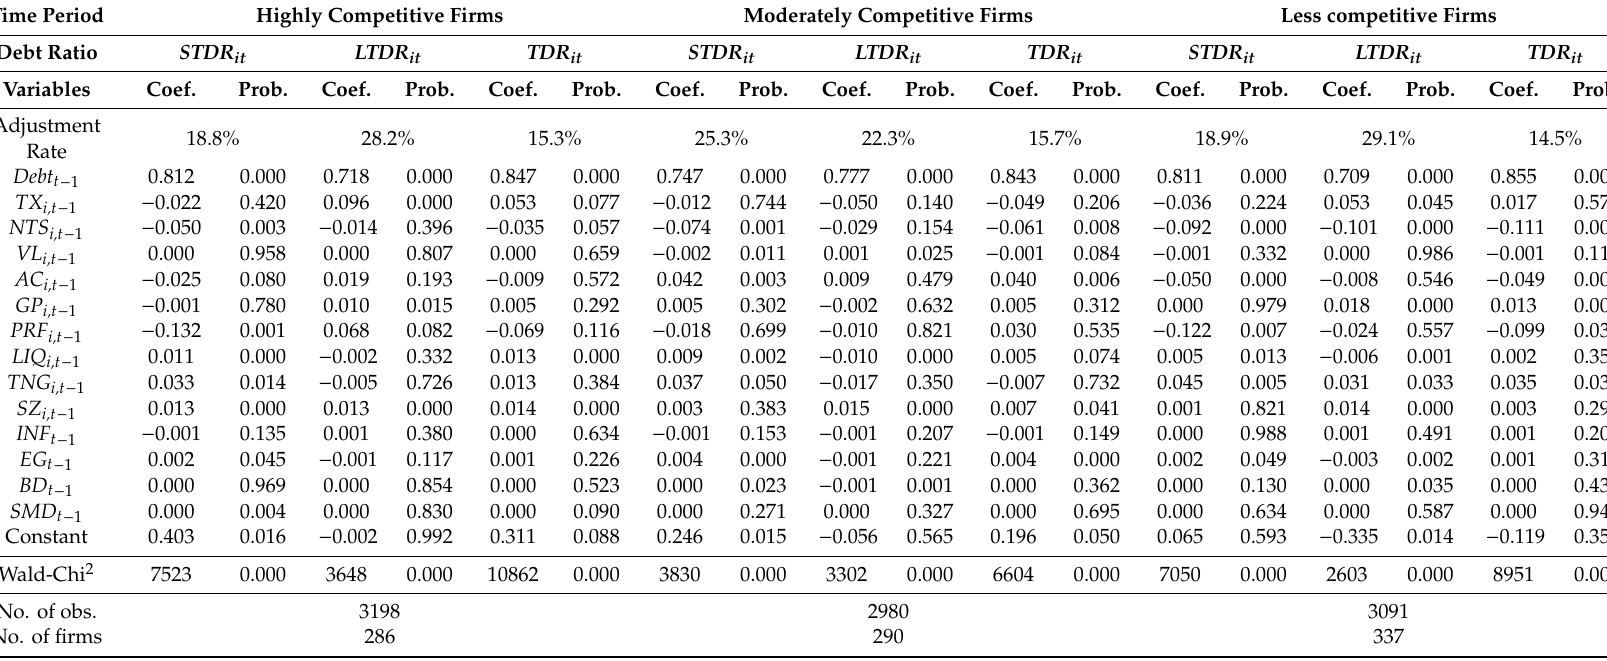
Table 7. Adjustment rate towards target capital structure and product market